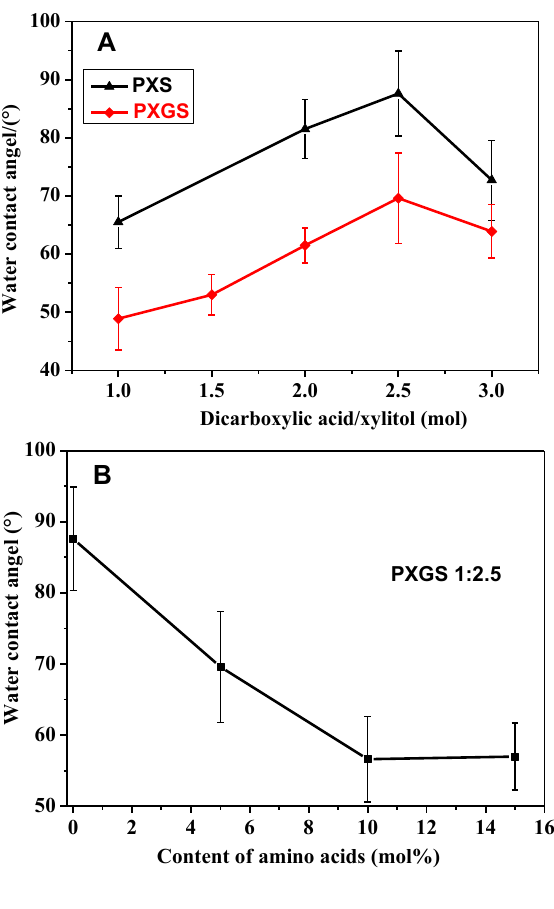
Figure 7. Water contact angles of the PXS and PXGS: ( A ) PXS and PXGS as a function of acid/xylitol ratio; ( B ) PXGS 1:2.5 with various contents of Boc- L -glutamic